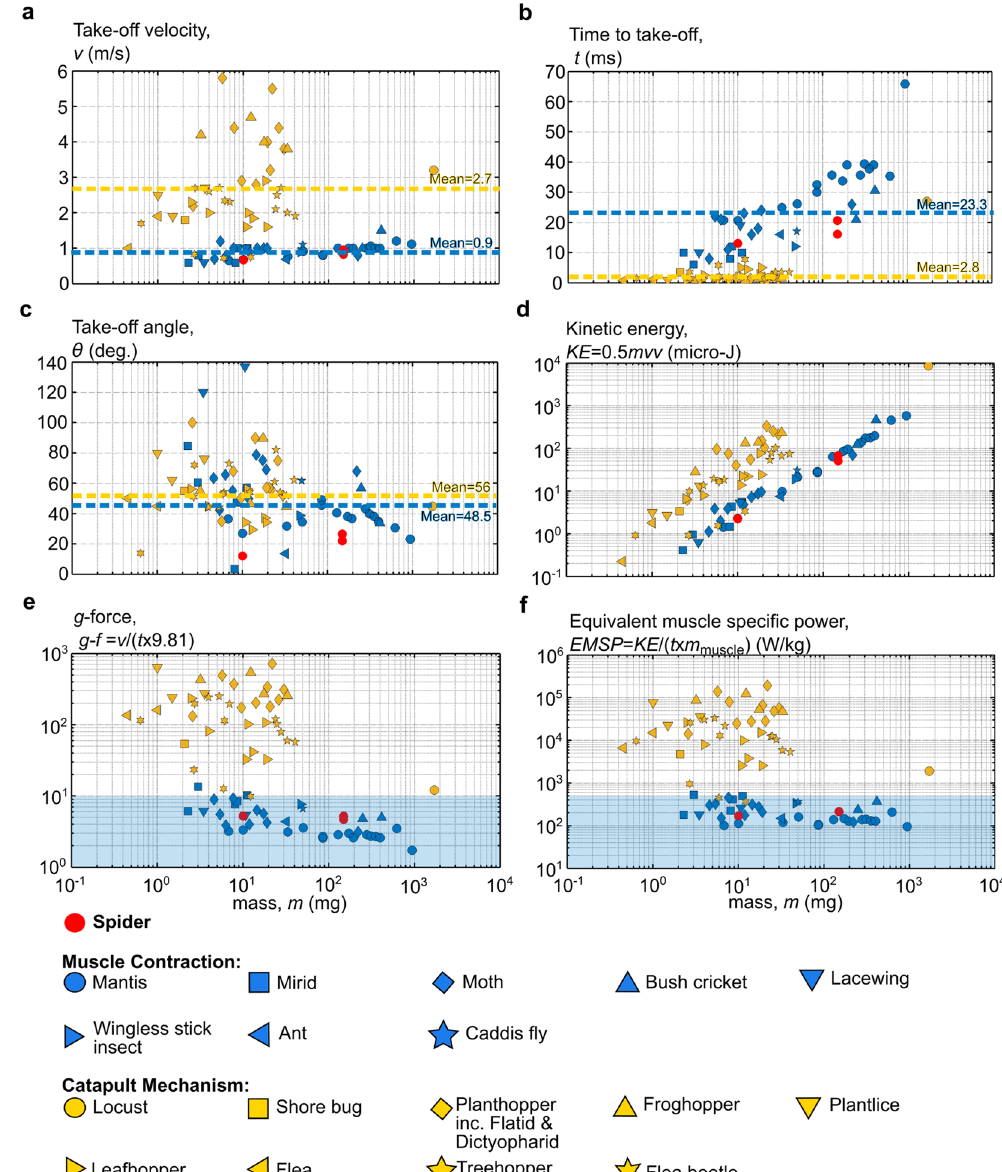
Figure 8. Comparison of the jumping characteristics of the different insects. Spiders are highlighted with red circles. Insects are classified into two main groups: a muscle contraction group and a catapult mechanism group. The sub-figures are: ( a ) The velocity magnitude at take-off, ( b ) time to take-off, ( c ) trajectory angle at take-off, ( d ) kinetic energy of the jump, ( e ) the ratio of the jumping acceleration at take-off to gravitational acceleration ( g -force), and ( f ) the specific power of the jump relative to the muscle mass. Full data and supporting references are provided in Supplementary Dataset